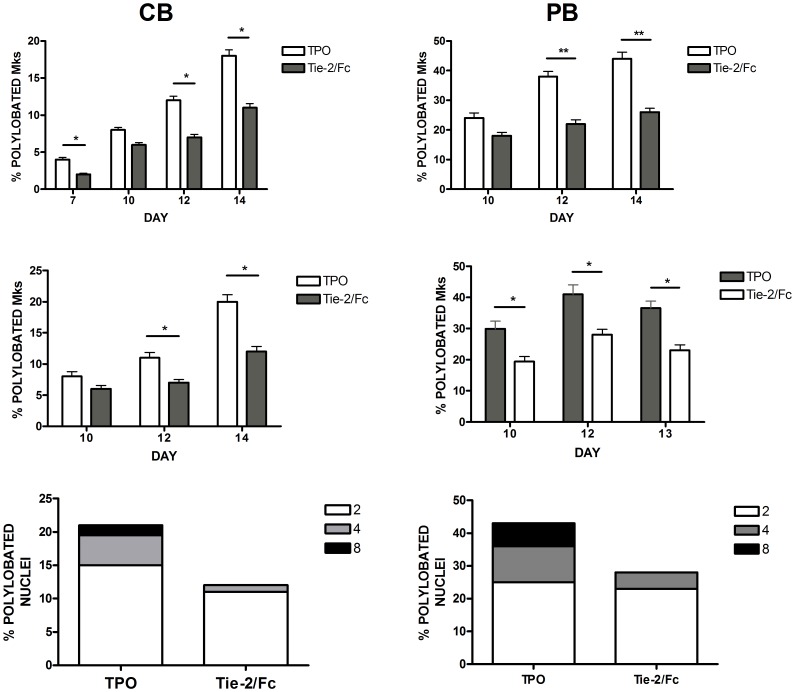
Effect of endogenous angiopoietin neutralization by Tie-2/Fc on Mk polyploidization in normal megakaryocytes.CB (left panels) or PB (right panels) CD34+ cells have been grown in the presence of TPO to induce Mk differentiation either in the absence (TPO ) or in the presence of Tie-2/Fc (TPO+Tie-2/Fc); Tie-2/Fc was added either at day 0 of culture (top panels) or at day 7 of culture (middle and bottom panels). The data reported in bottom panels are derived from day 14 CB Mks and day 12 PB Mks. Cell aliquots were harvested at various days of culture, cytocentrifuged, stained with MGG and through microscopic inspection the proportion of cells displaying 2, 4 or 8 nuclei lobi was determined. The data reported in the Figure represent the mean values ± SEM observed in three separate experiments. * p<0.05.